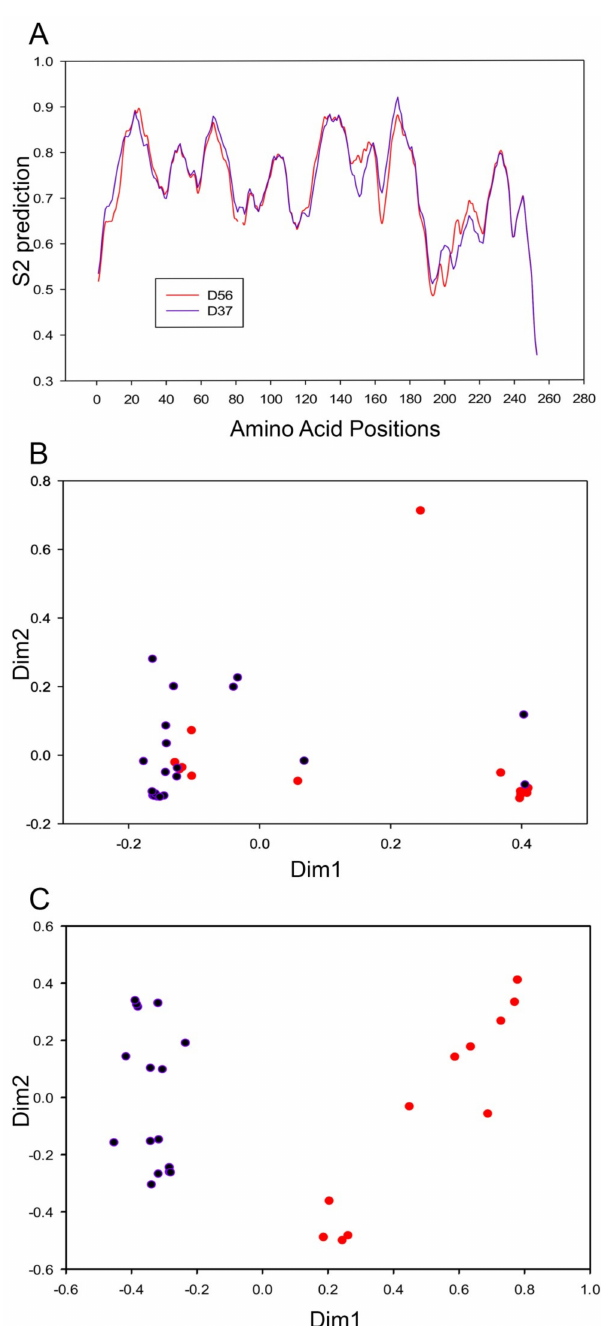
Figure 5. Divergence in structural flexibility and codon usage bias of the E1A protein. ( A ) DynaMine S2 predictions for E1A 13S protein flexibility and disordered regions for HAdV-D56 and HAdV-D37. Regions with S2 prediction values below 0.7 are flexible, while regions with values above 0.8 are rigid. The CR3 region is the origin for the difference in protein dynamics (at the 140–160 amino acid position) between HAdV-Ds. ( B and C ) Codon usage bias of 38 HAdV-Ds for 59 codons as summarized by two-dimensional plot performed with correspondence analysis for the E1A 12S isoform ( B ) and the 13S CR3 region alone ( C ). Purple color dots represent HAdV-Ds belonging to the one group, while red color dots represent the other. The difference in codon usage bias for the CR3 region indicated its evolution in different cellular environments for each